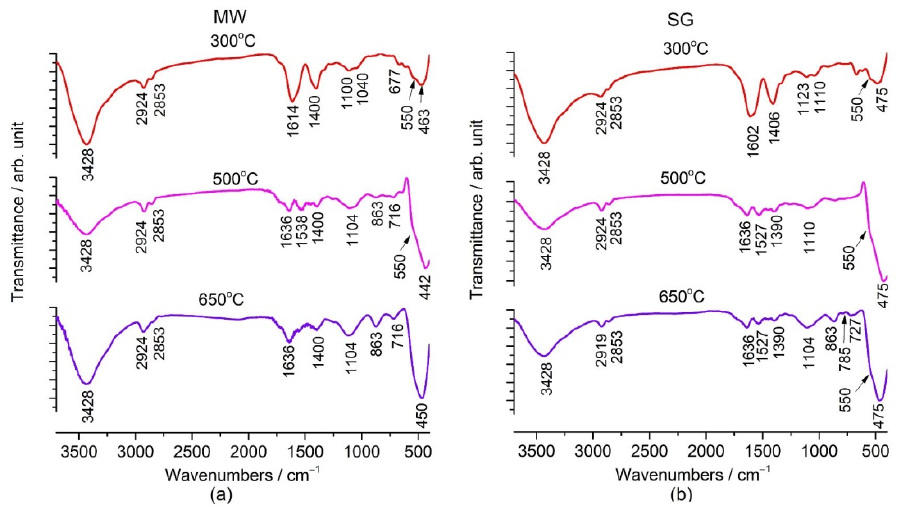
Figure 6. FTIR spectra of the thermally treated powders at 300 ◦ C, 500 ◦ C, and 650 ◦ C for: ( a ) the Figure 6 . FTIR spectra of the thermally treated powders at 300 °C, 500 °C, and 650 °C for: ( a ) the microwave assisted sol–gel method (MW) and ( b ) the sol–gel method microwave assisted sol–gel method (MW) and ( b ) the sol–gel method (SG).